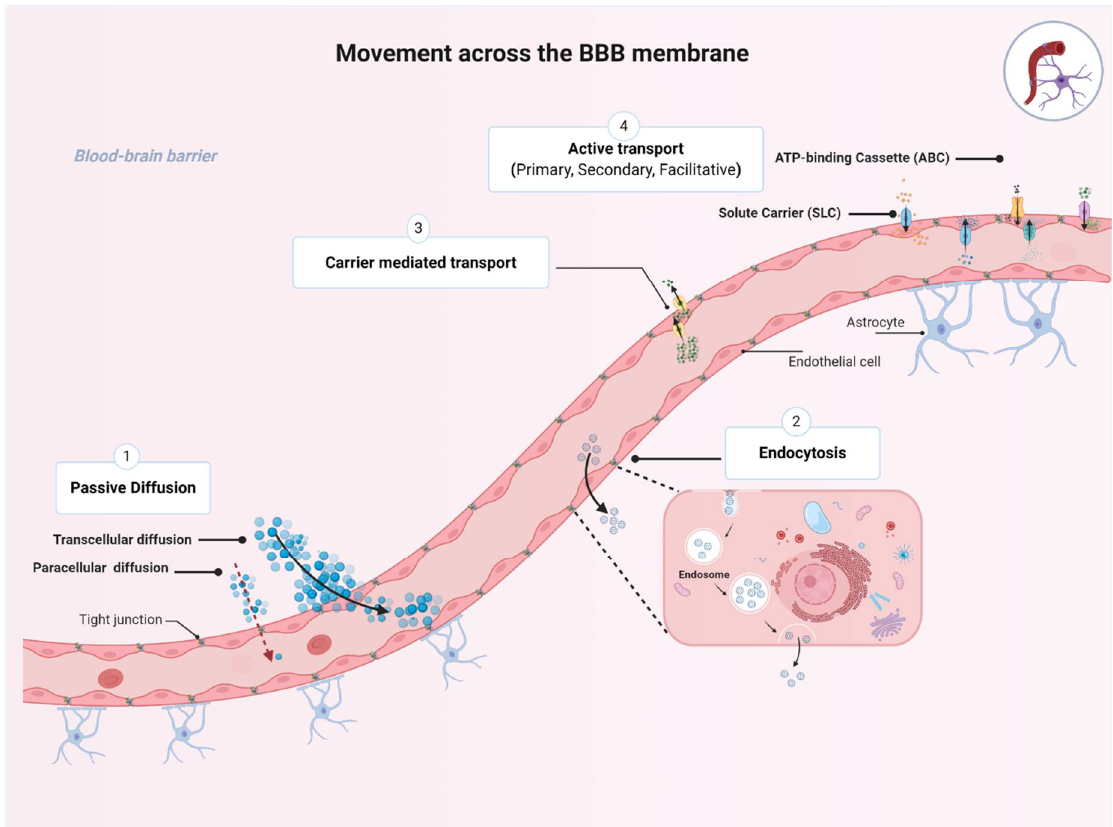
Figure 2. Transport pathways across the blood–brain barrier (BBB). The passage of various molecules through the brain implies four basic mechanisms allowing specific molecules to move across the BBB membrane including: ( 1 ) the passive diffusion (spontaneous movement across a concentration gradient), ( 2 ) endocytosis (receptor-mediated, adsorptive, or bulk-phase endocytosis), ( 3 ) carrier-mediated transport (movement across a concentration gradient and energy independent), and ( 4 ) active transport (movement of molecules against a concentration gradient and energy dependent). Collectively, the four mechanism plays an essential role for maintaining brain homeostasis. (Created with BioRender, accessed on 27 January 2021).